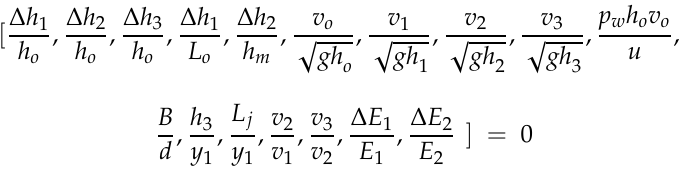
Figure 4. Experimental model of the hybrid defense system (HDS).